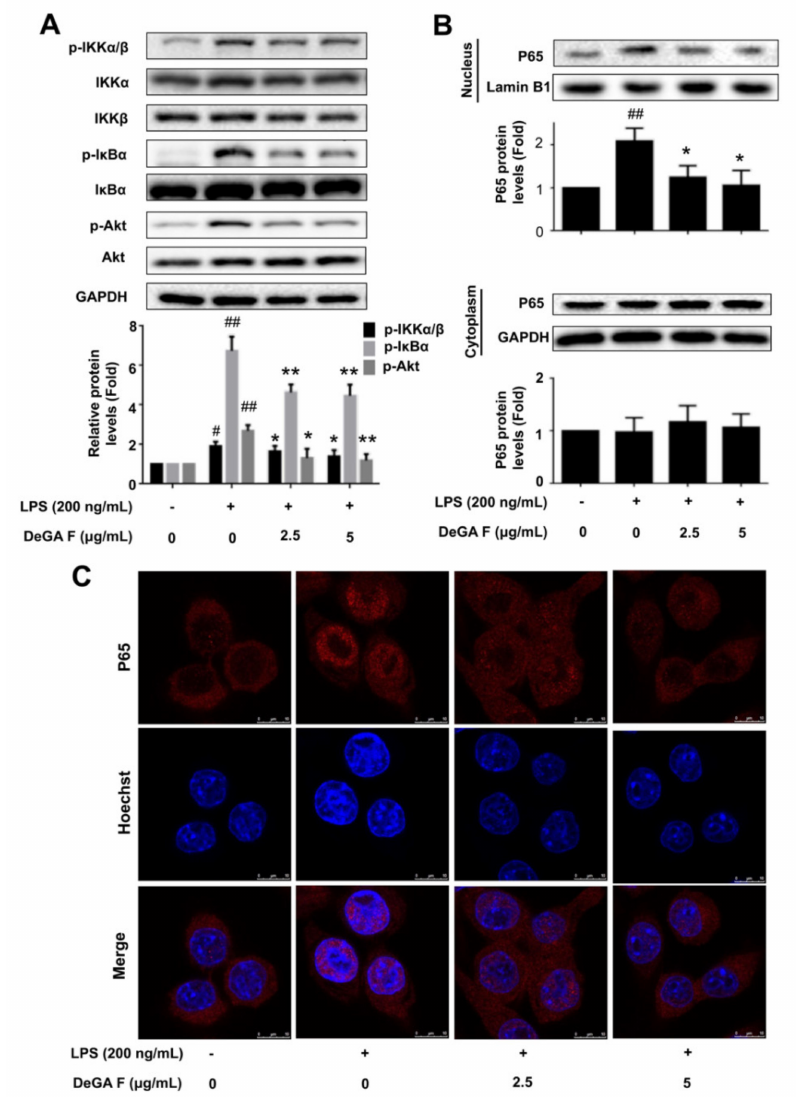
Figure 3. DeGA F suppressed LPS-triggered activation of NF- κ B pathway in BV-2 cells. Cells were pretreated with DeGA F for 1 h, and then exposed to LPS for another 3 h. ( A ) Expression of relative proteins were determined by Western blot analysis. ( B ) Nuclear and cytoplasmic proteins were extracted and expression levels of P65 were detected by Western blot. ( C ) Nuclear translocation of P65 was evaluated by immunofluorescence analysis. Cells were stained with anti-P65 antibody (red) and Hoechst (blue). – and + represented the absence or presence of LPS (200 ng / mL), respectively. # p < 0.05 and ## p < 0.01 compared with blank group. * p < 0.05 and ** p < 0.01 compared with the LPS group ( n =